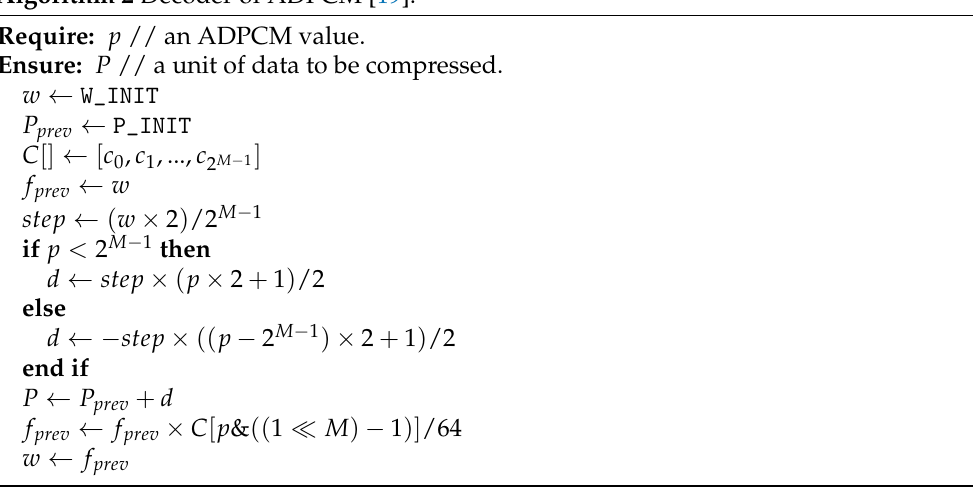
Algorithm 2 Decoder of ADPCM